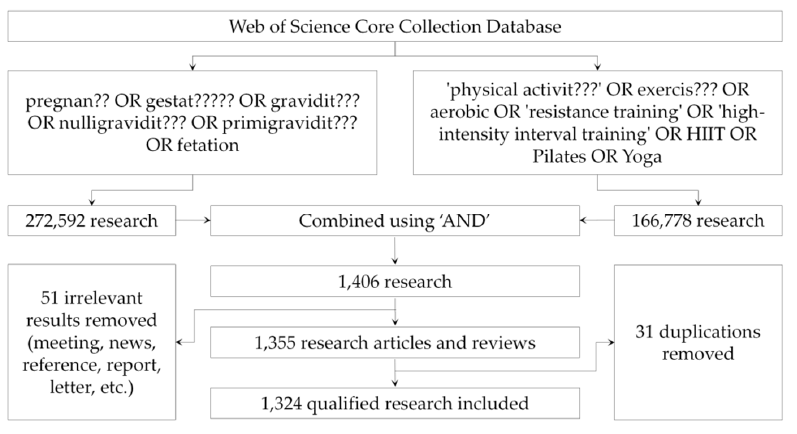
Figure 1. Retrieval strategy.